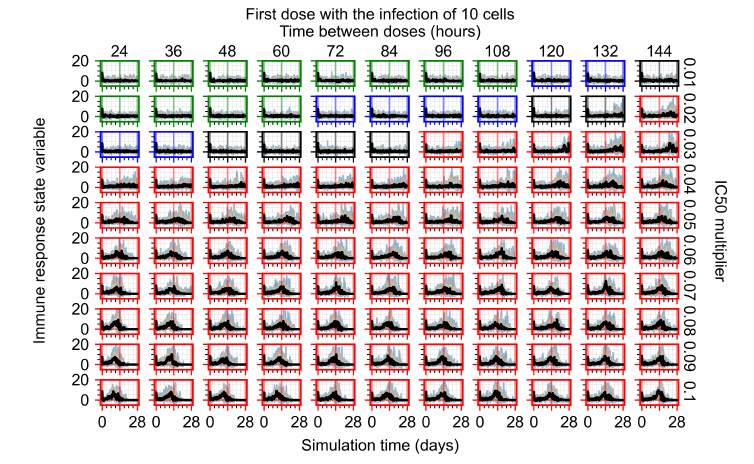
Figure A47. Immune response state variable number. Positive values correspond to an inflammatory state, and negative to an anti-inflammatory state.